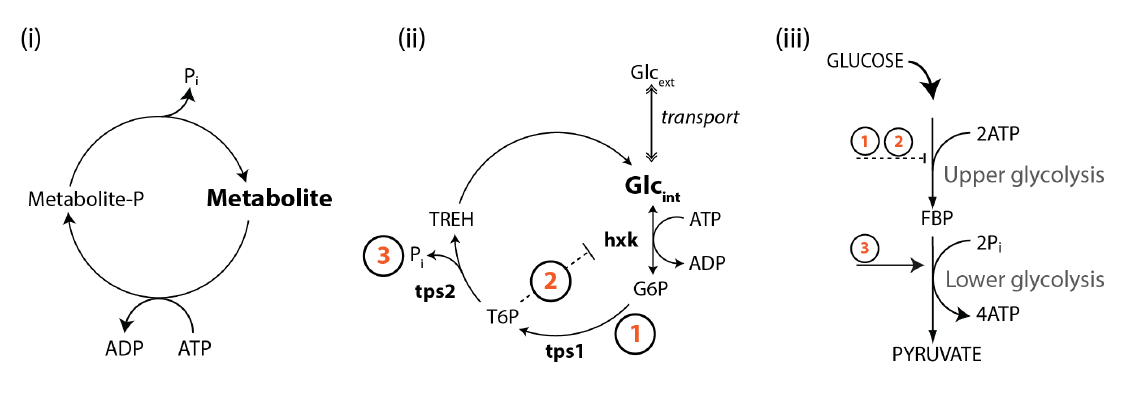
FIGURE 2: All the defining features of a futile cycle (i) are present in the full trehalose cycle (ii) . Balancing upper- and lower-glycolytic fluxes during the initiation of glycolysis is achieved by a combination (iii) of features inherent in the trehalose cycle. The specific regulatory com- ponents include: (1) ATP hydrolysis and substrate removal and (2) T6P-mediated inhibition of hxk activity, which together slow down the upper-glycolytic flux, and (3) P i liberation, which functions to stimulate lower glycolysis. Glc, glucose; G6P, glucose 6-phosphate; TREH, tre- halose; tps2, trehalose 6-phosphate